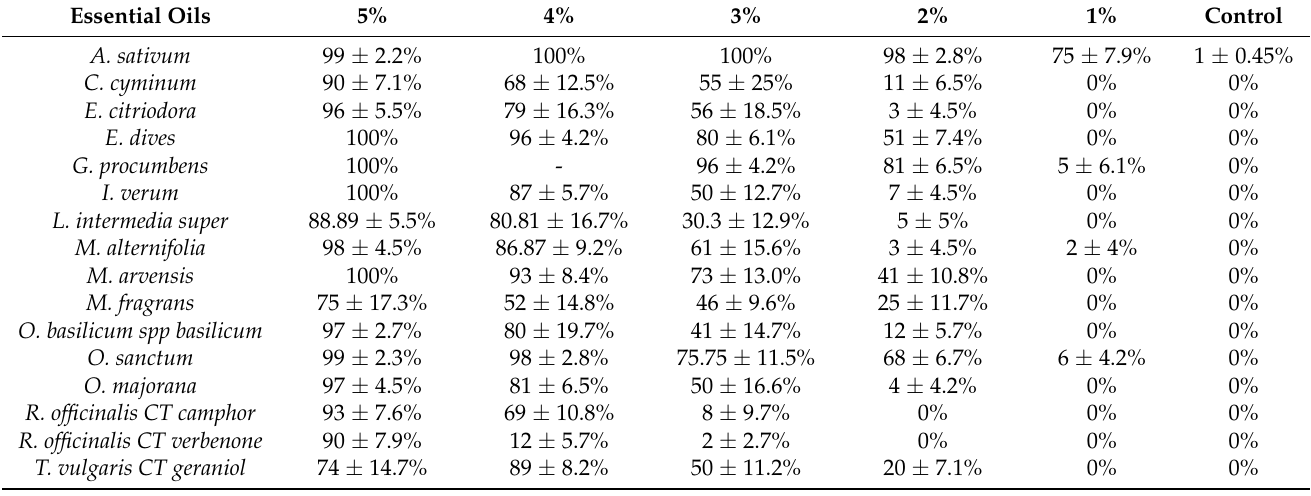
Table 3. Summary of mortality percentages after 24 h hours of exposure for the concentrations tested ( n = 5). Essential Oils